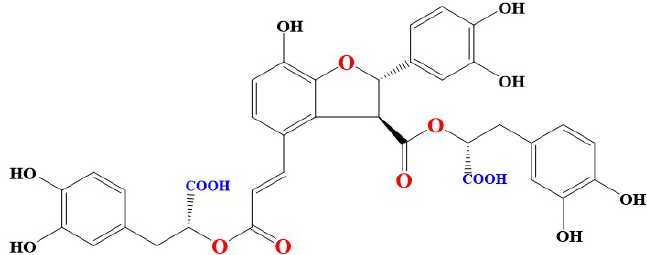
Figure 1. Chemical structure of salvianolic acid B